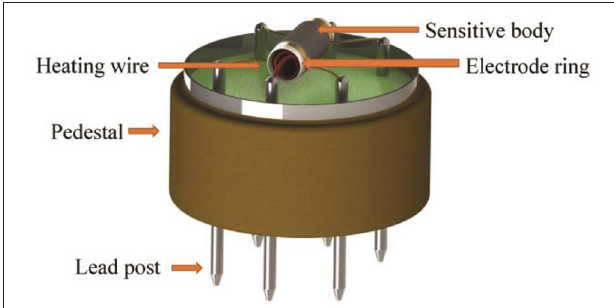
FIGURE 5 | The MQ-8 sensor structure diagram.